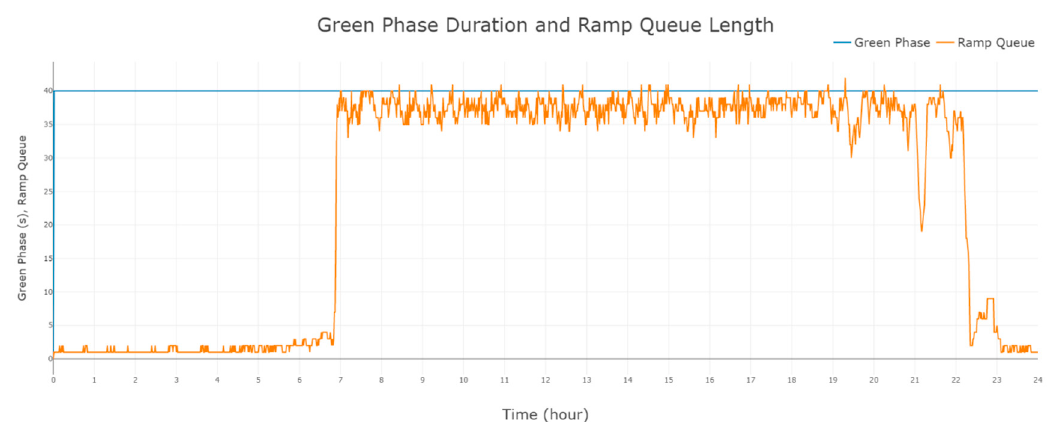
Figure 12. Green phase duration and ramp queue length—no control scenario.